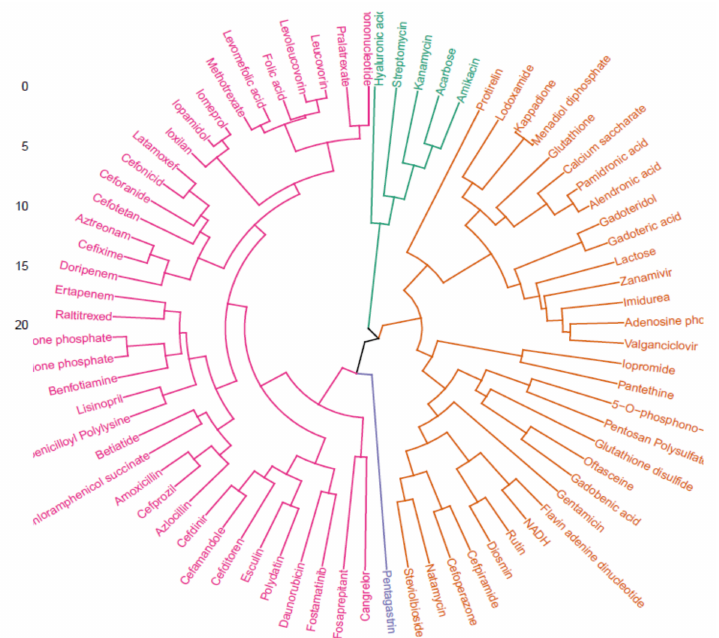
Figure 6. Circular hierarchical cluster analysis (HCA) dendrogram of Cluster II using Euclidean distances and average linkage showing four clusters. Each cluster is colored differently.